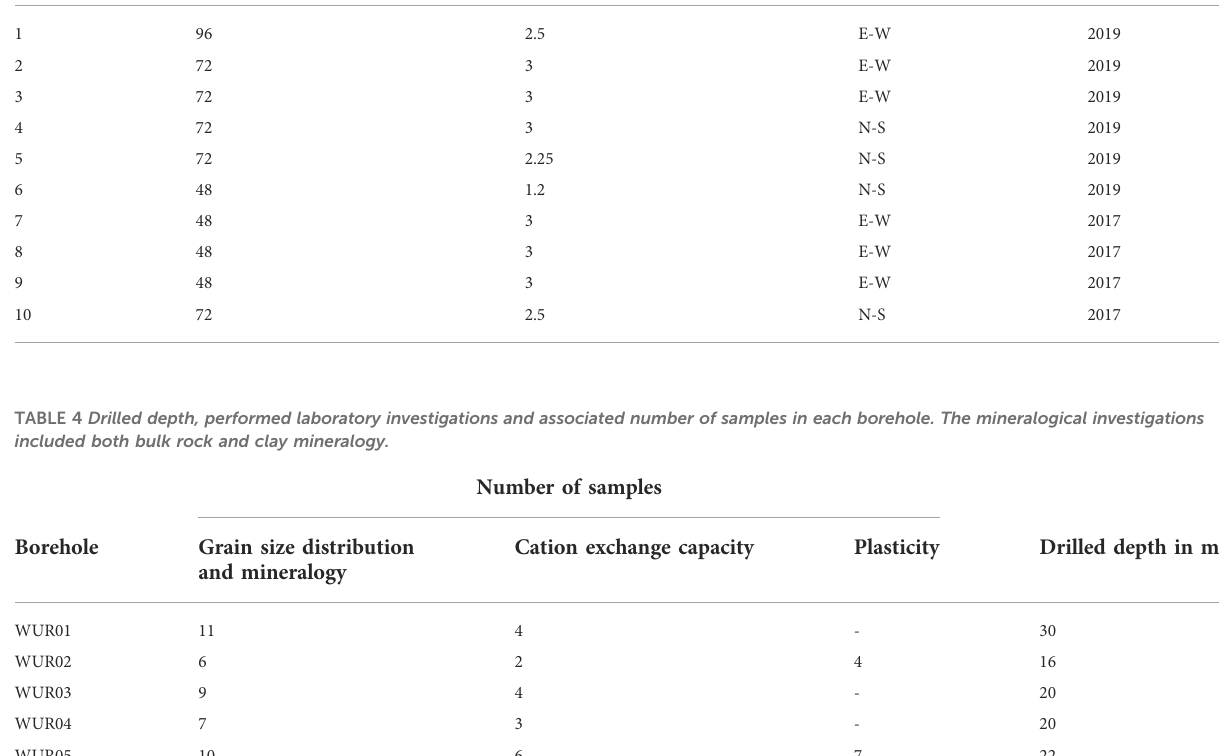
TABLE 3 Number of deployed geophones, the geophone spacing, the orientation and year of collection of the seismic pro fi le. Pro fi le